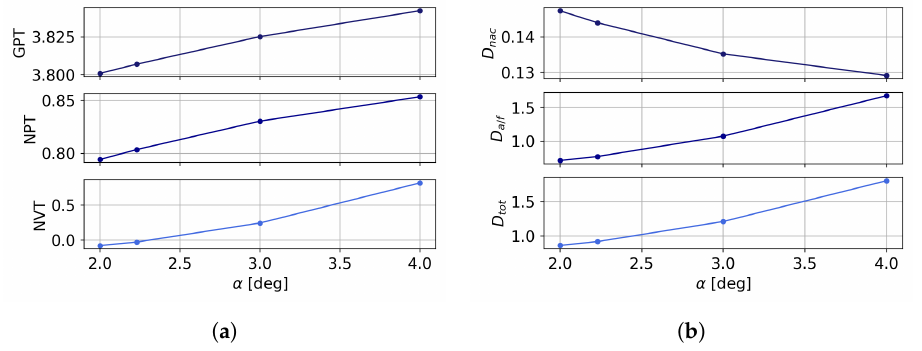
Figure 8. Variation of thrust and drag forces with the angle of attack. All data are normalised by a reference net thrust. ( a ) Thrust; ( b )